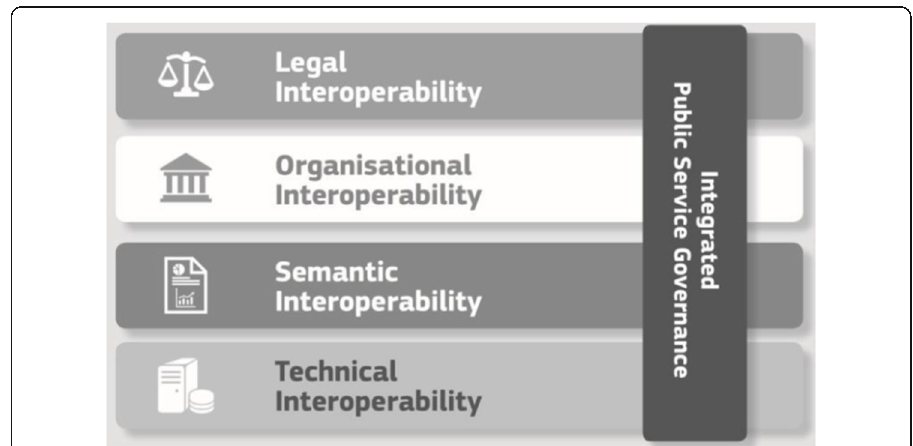
Fig. 4 European Interoperability Framework (from EU,